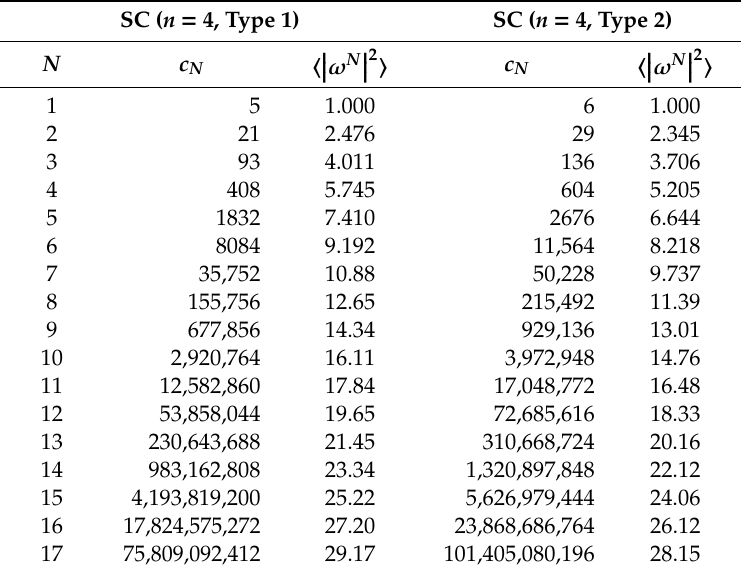
Table A5. Properties of SAWs on SC lattice with four layers between the confining plates ( n = 4, Type 1, 2).